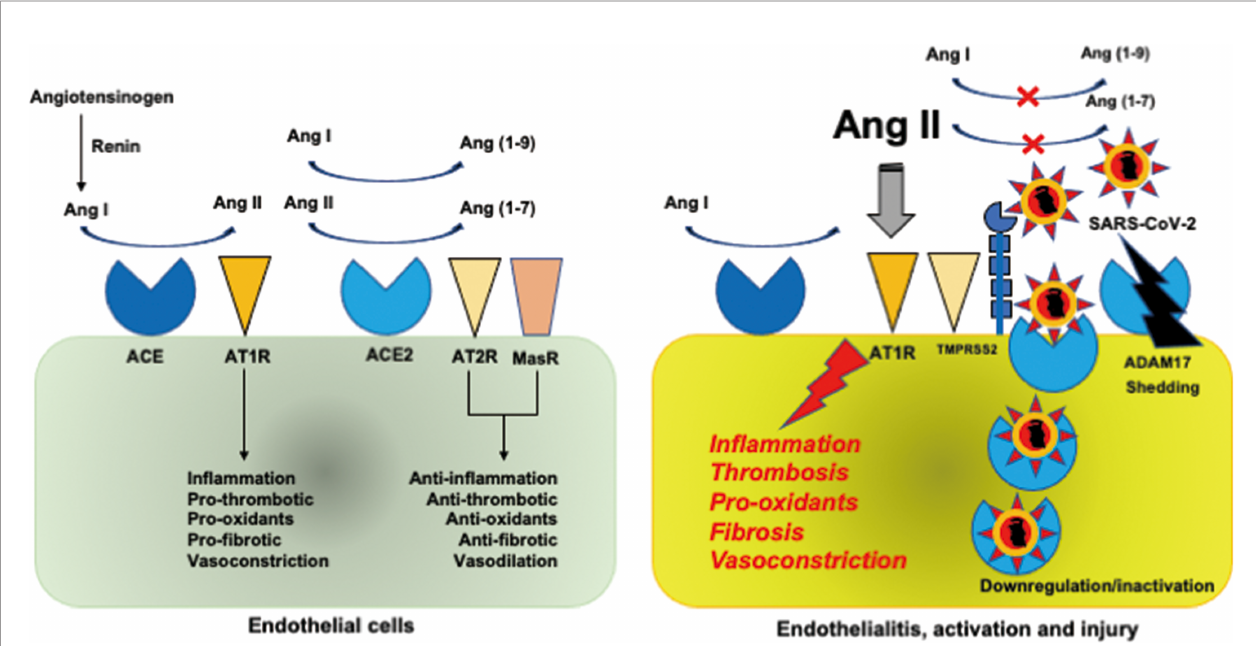
FIGURE 1 | Renin-angiotensin-aldosterone system. (Left). Renin converts angiotensinogen to Ang I, which is converted to Ang II by ACE. ACE2 degrades Ang I and Ang II to generate Ang(1-9) and Ang(1-7), which have anti-in fl ammatory and antithrombotic actions through AT2R and MasR. Conversely, Ang II has proin fl ammatory and prothrombotic properties binding to AT1R and secretes aldosterone from the adrenal cortex. RAAS is balanced by its two opposed properties of in fl ammation and coagulation by ACE2. (Right). Binding of SARS-CoV-2 to ACE2 via the spike glycoprotein to TMPRSS2 results in the downregulation and inactivation of ACE2, leading to an increase in Ang II levels, which gives rise to in fl ammation and thrombosis through AT1R. Proteolysis and shedding of ACE2 resulting from ADAM17 upregulation also contributes to inactivation of ACE2. SARS-CoV-2 infection of endothelial cells causes endothelialitis associated with endothelial activation and injury. ACE, angiotensin-converting enzyme; ADAM17, a disintegrin and metalloprotease domain-containing protein 17; Ang, angiotensin; AT1R, angiotensin II type 1 receptor; MasR, Mas receptor; RAAS, renin-angiotensin-aldosterone system; SARS-CoV-2, severe acute respiratory syndrome coronavirus 2; TMPRSS2, transmembrane protease serine type